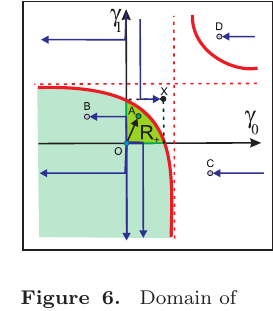
Figure 6. Domain of regularity R and connected